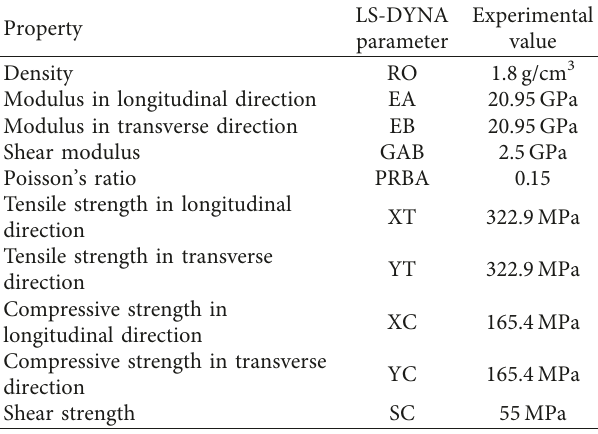
Table 3: Material parameters of the GFRP face sheets.